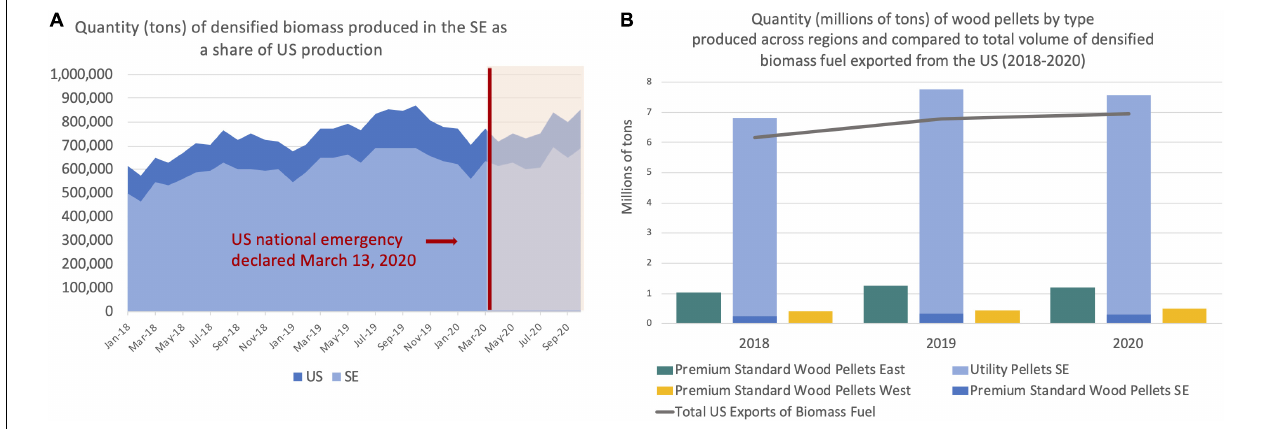
FIGURE 2 | (A) Quantity (tons) of pellets produced monthly in the SE United States as share of total United States production, January 2018–October 2020 and (B) Quantity of pellets produced annually in the United States by region and type of pellet, relative to annual United States export volumes. United States exports are comprised almost exclusively of utility